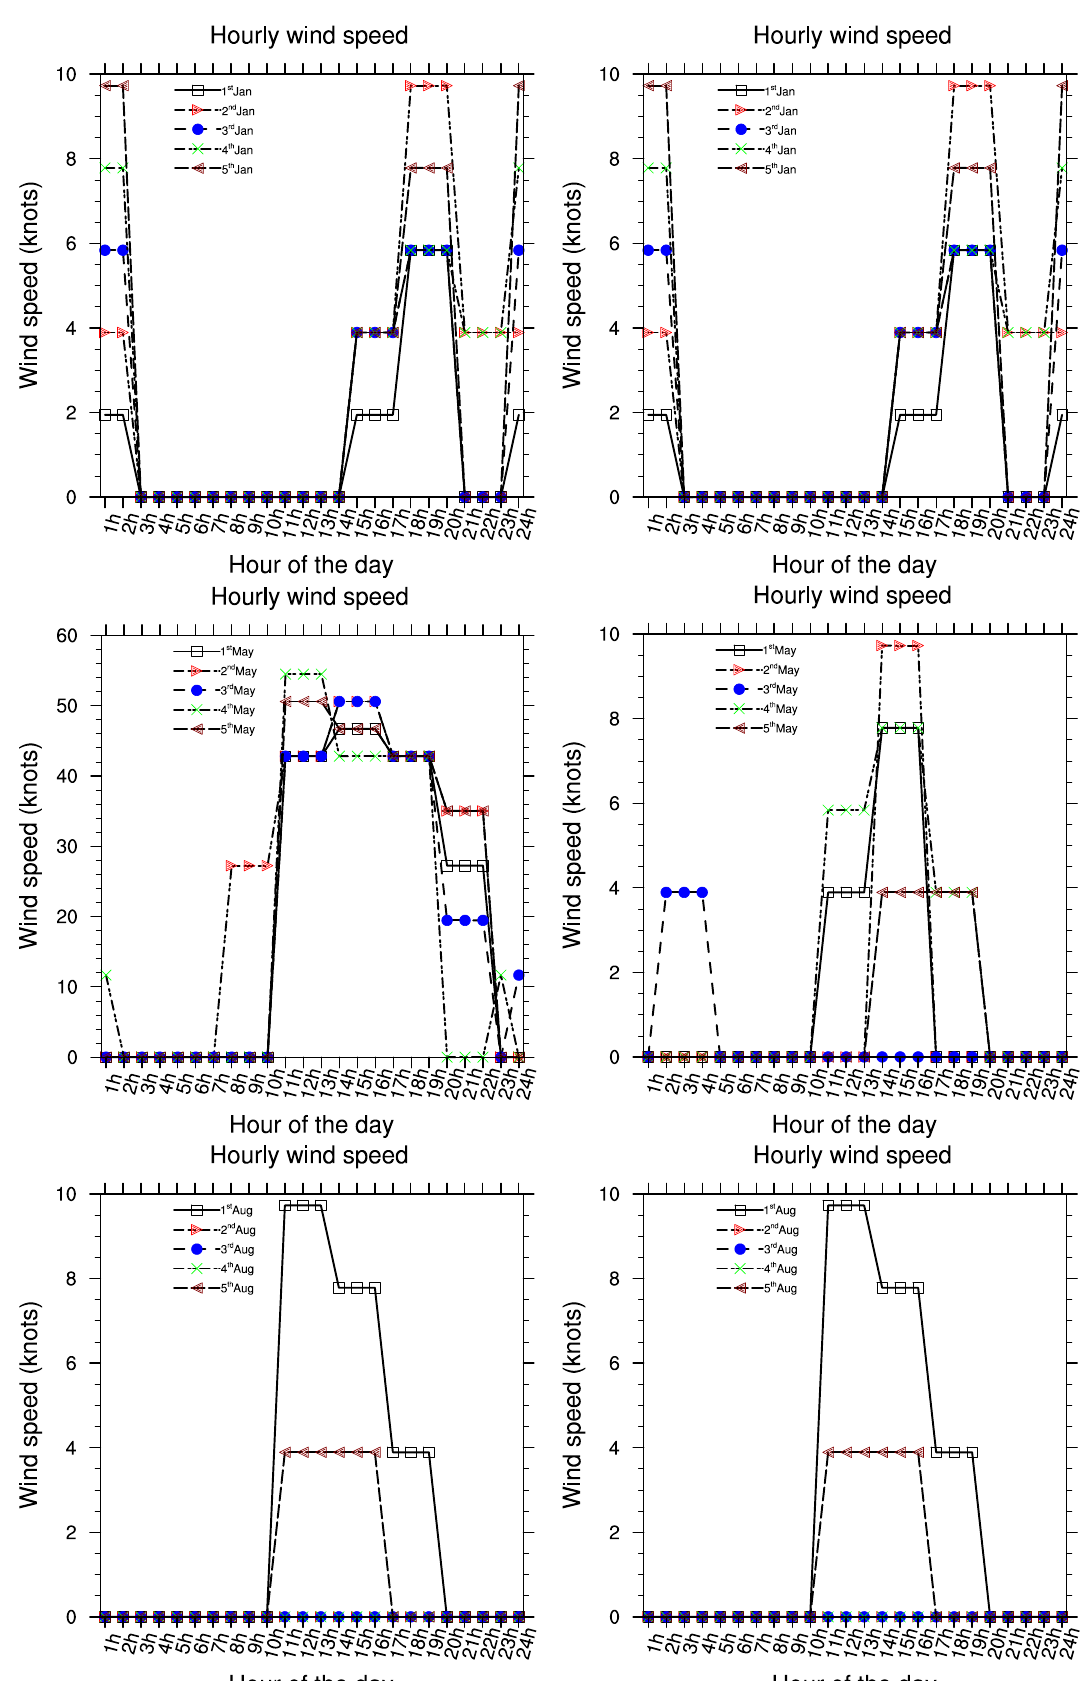
Figure 6. Daily wind speed for the first five days of the months of January, May and August from 2004 to 2005. The first label is for the year 2004 and the second label (column) is for the year